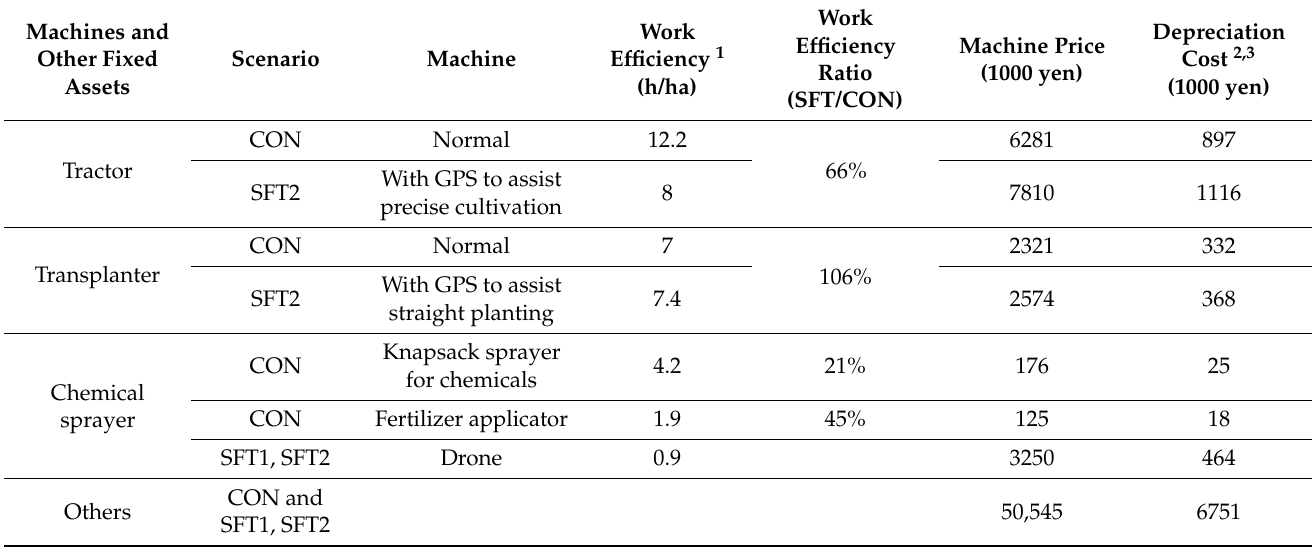
Table 2. Labor and operating costs of the three